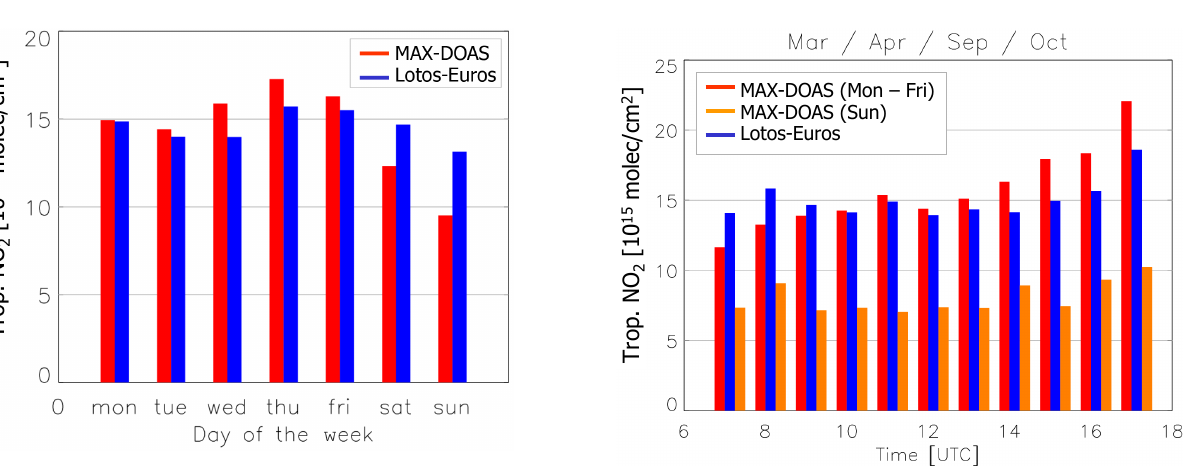
the day on weekdays and Sundays, based on the months March, April, September and October in the data set (some months oc- curred twice; see Fig. 8). These months were grouped because they have approximately the same daylight period. Winter months show a similar behavior (higher MAX-DOAS values in the afternoon). Summer months were not present in the data set. Sundays were only shown for the observations for reasons of clarity: the weekend effect (Fig. 9) would complicate the